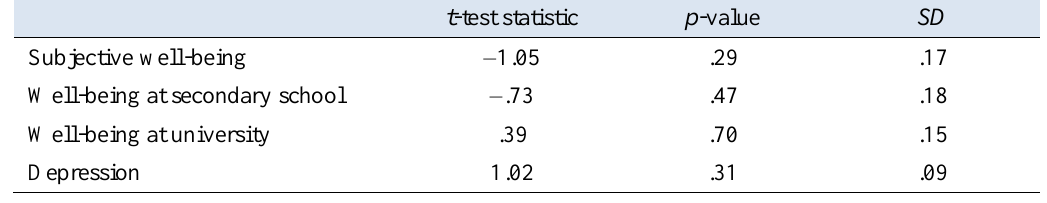
Retention analysis on students who completed Time 1 assessment and students who completed Time 1 and Time 2 assessments for indicators of well-being at Time